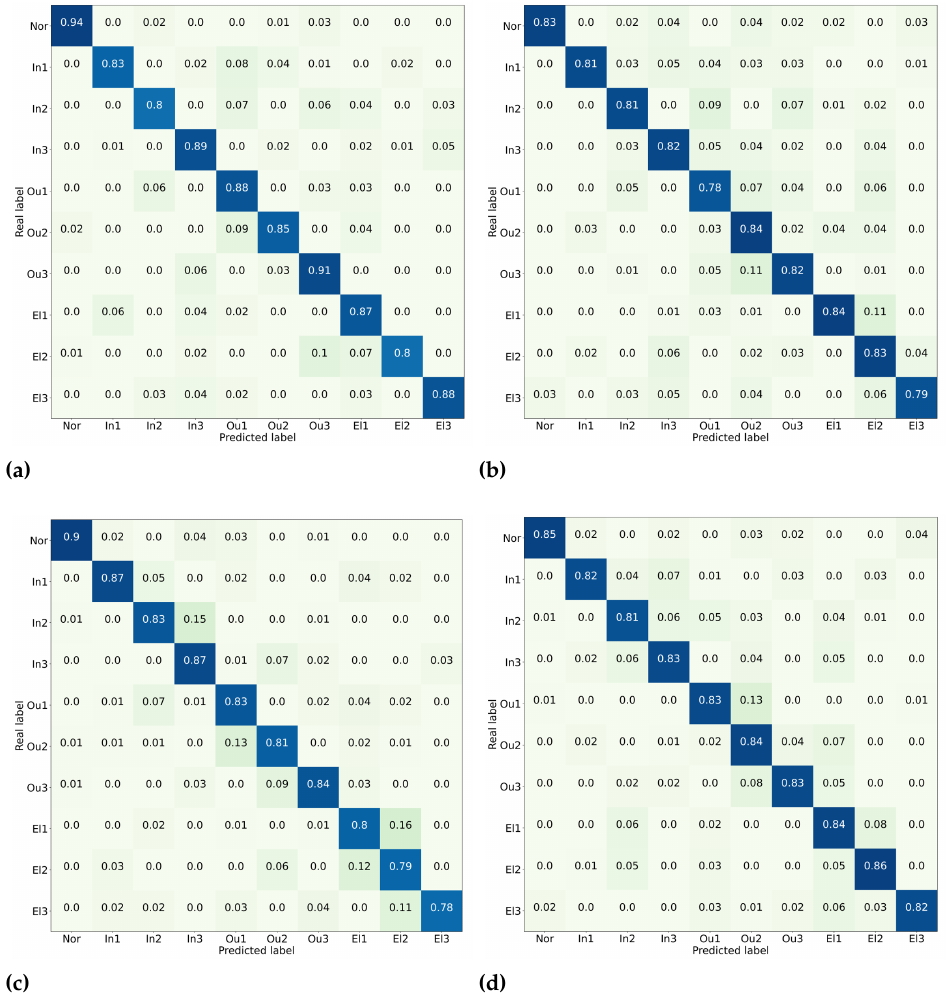
Figure 12. Confusion matrices for different methods. ( a ) Proposed method; ( b ) VGG19; ( c ) ResNet50; ( d )